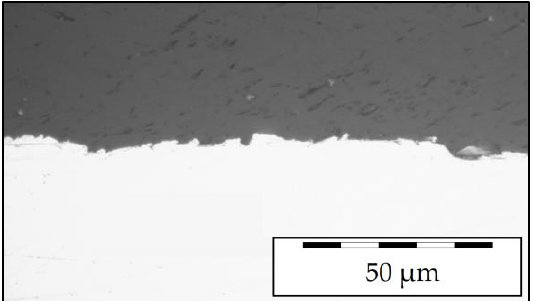
Figure 1. Micrograph of the polymer steel interface with well infiltrated rough metal surface.